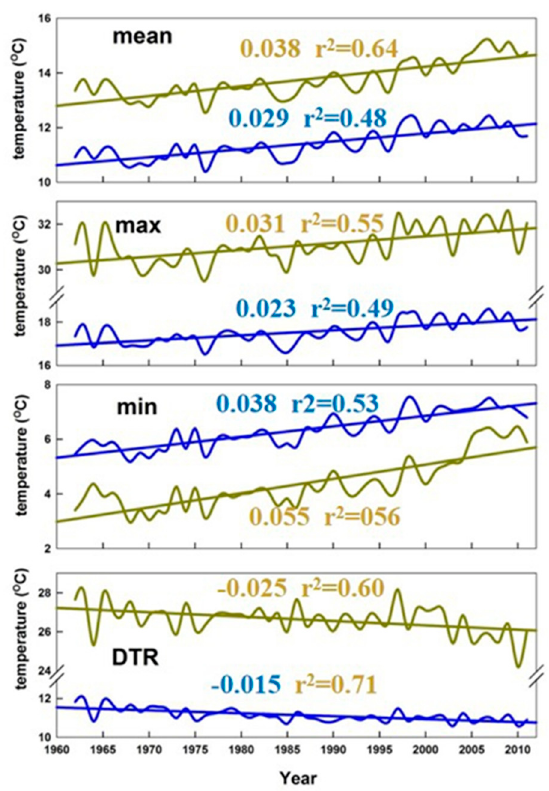
Figure 9. Time series and linear trends from annual means of ST mean , ST max , ST min , SDTR (yellow lines and numbers), AT mean , AT max , AT min , DTR (blue lines and numbers) for China during 1962–2011. Values along the trends lines are rate of change (°C/year), all the slopes of trends were significant ( p < 0.05).